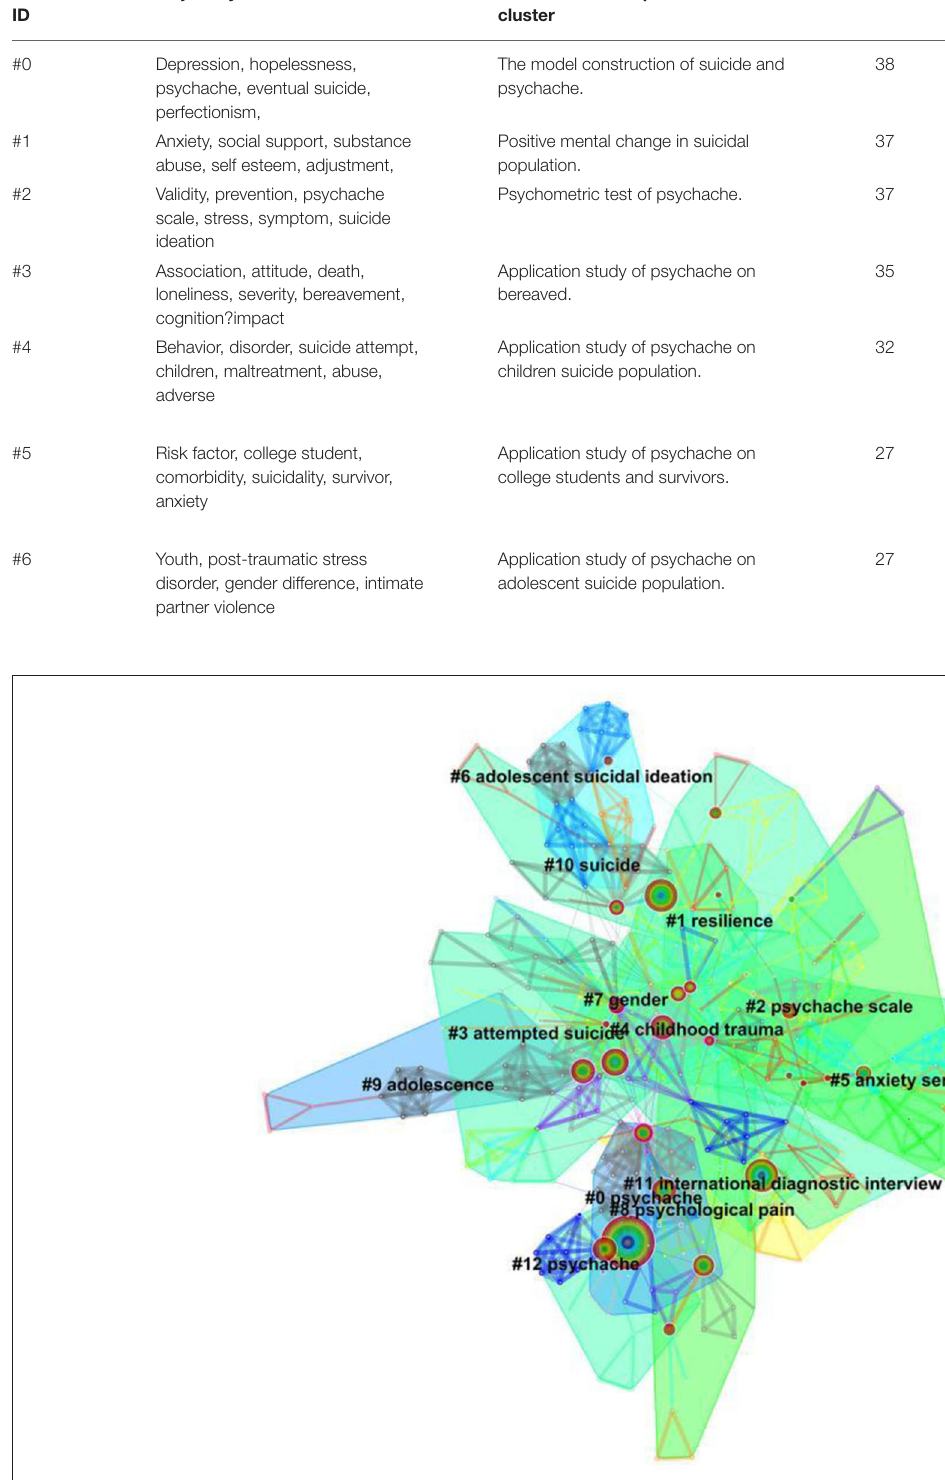
Silhouette value